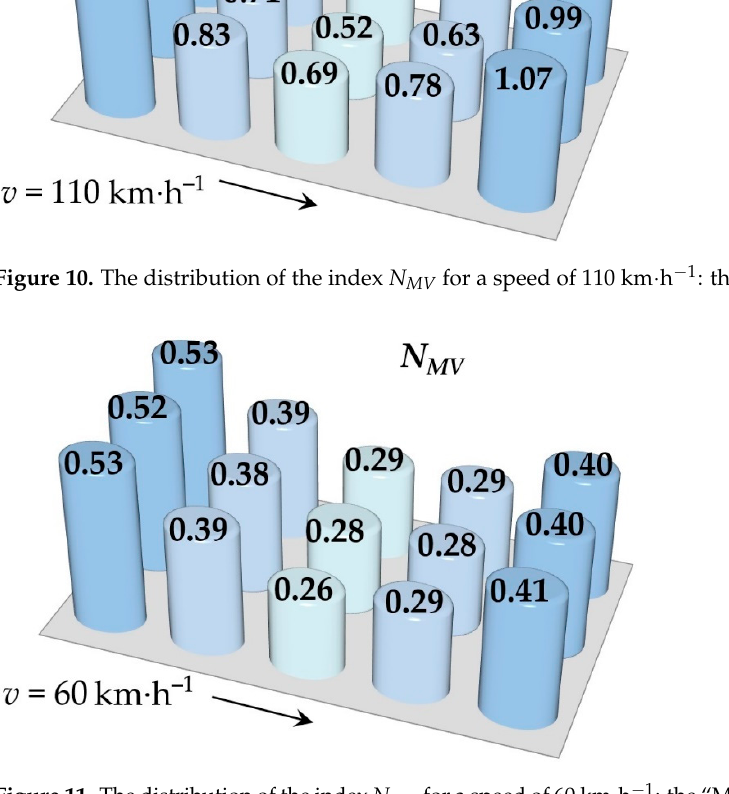
Figure 12. The distribution of the index N MV for a speed of 110 km ∙ h − 1 : the “Modification I” param- eters. Figure 13. The distribution of the index N MV for a speed of 60 km ∙ h − 1 : the “Modification II” parame- ters.